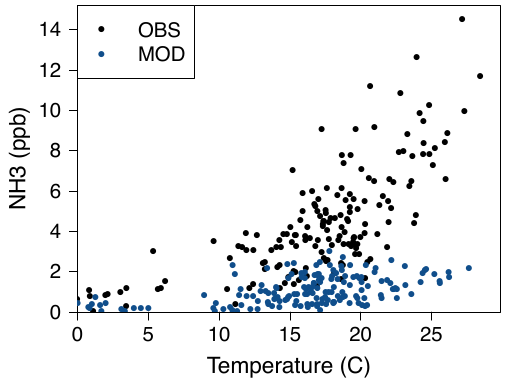
Figure 4. Daily observed (in black) and modeled (in blue) NH 3 concentrations vs. temperature in Paris (for the model, only days with available observations are plotted).